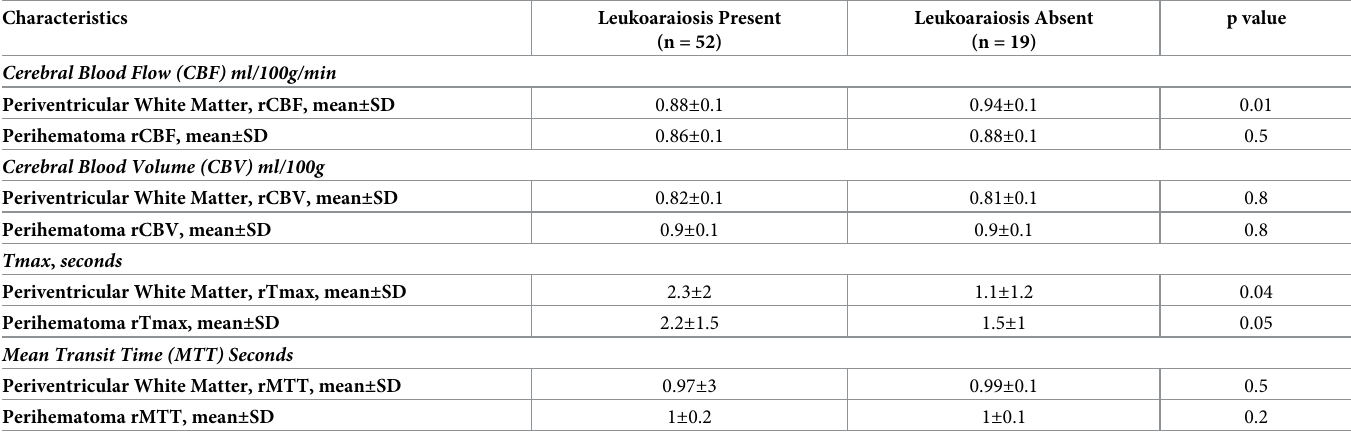
Table 2. Cerebral perfusion characteristics in patients with and without leukoaraiosis. Characteristics